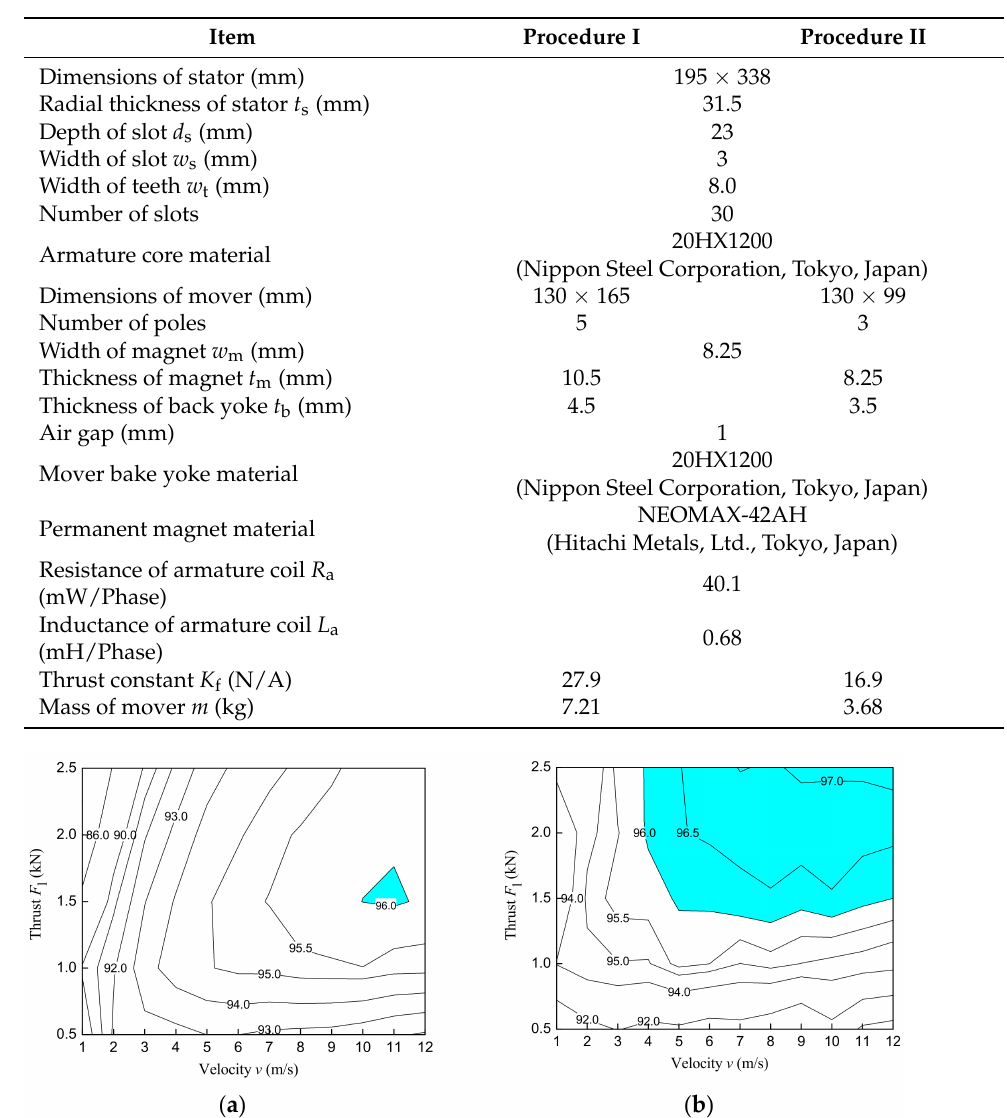
Table 1. Specifications of generators.